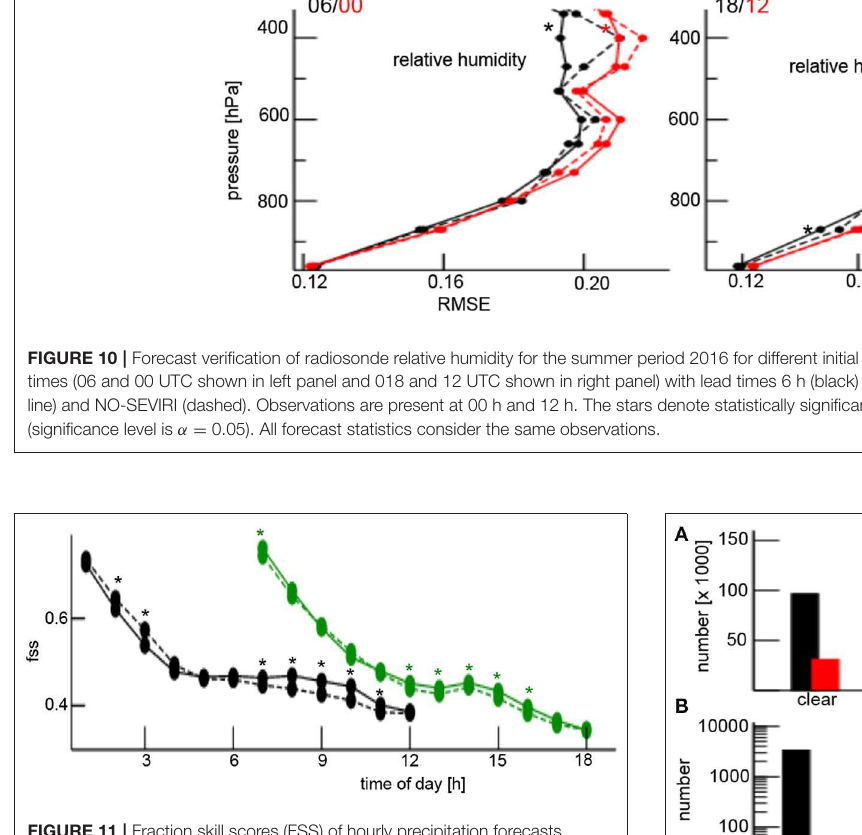
FIGURE 11 | Fraction skill scores (FSS) of hourly precipitation forecasts against radar-derived precipitation as a function of time of day for summer period 2016. The plot shows forecasts of experiments NO-SEVIRI (dashed) and SEVIRI-NEW (solid) for lead times from 1 to 12 h, colors encode initial time 00UTC (black) and 06UTC (green). The stars denote significantly different scores between experiments (significance level is α = 0.10) based on bootstrap confidence interval. The precipitation threshold is 1.0 mm and scale diameter is chosen to 11 grid points ( ∼ 30km).